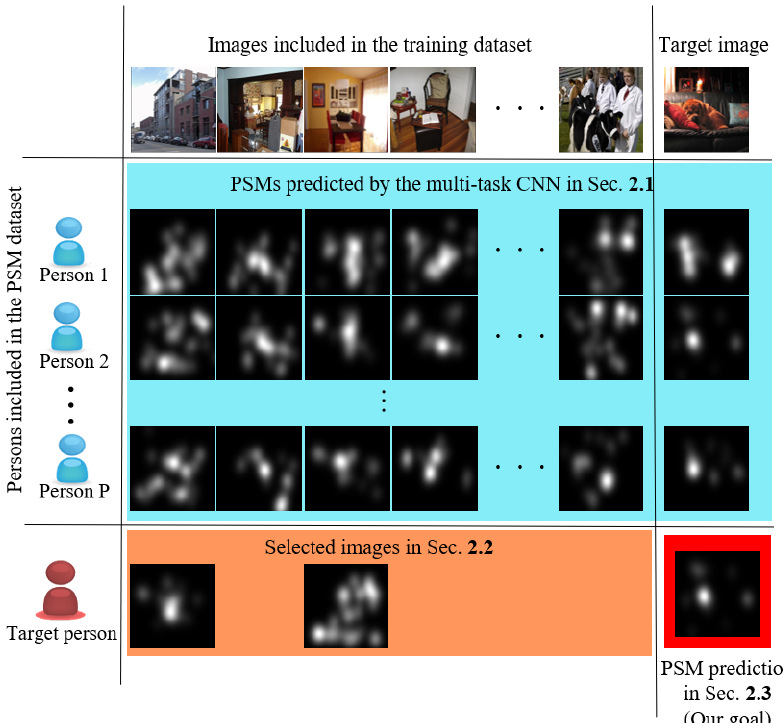
Figure 1. The problem setting of our study. The purpose of our study is Personalized Saliency Map (PSM) prediction of a target person for images not included in the training dataset. For predicting a PSM for a target image, the target person needs to view only some images, which have been viewed by persons included in the training PSM